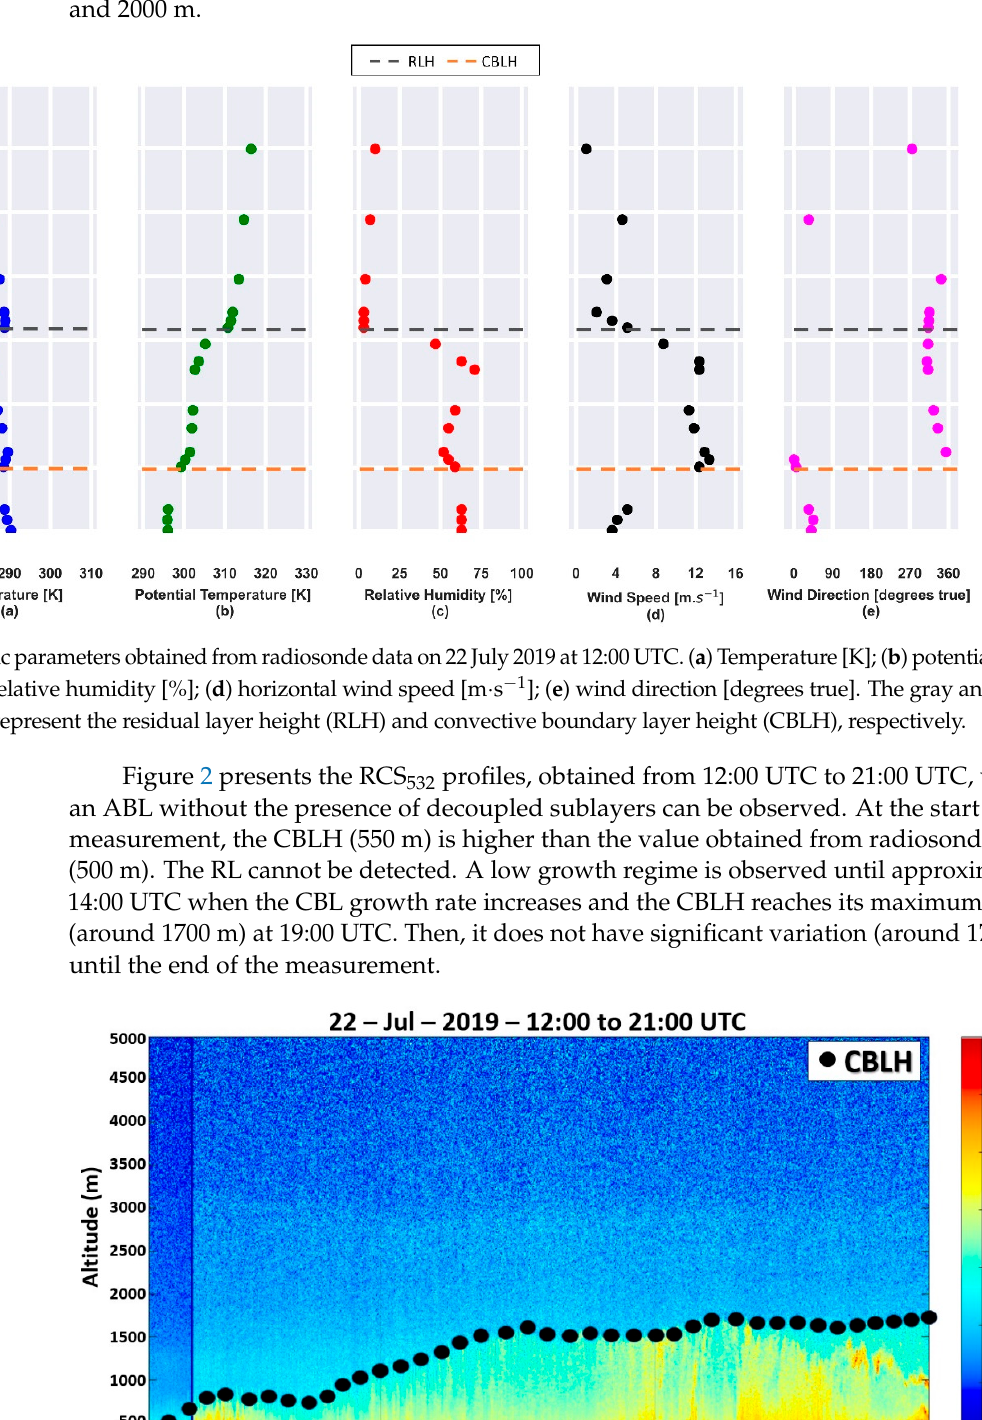
Figure 3. Atmospheric parameters obtained from radiosonde data on 23 July 2019 at 00:00 UTC. ( a ) Temperature [K]; ( b ) potential temperature [K]; ( c ) relative humidity [%]; ( d ) horizontal wind speed [m·s − 1 ]; ( e ) wind direction [degrees true]. The gray dashed line represents the RLH. Figure 4b presents the hourly-variation of AE (red dots) and the AOD (blue dots) between 13:00 UTC and 17:00 UTC. The increase in the AE between 13:00 and 14:00 UTC (0.73 to 1.42) indicates a reduction in the aerosols’ average size in the atmospheric column. Such a variation is accompanied by a reduction in the average AOD values (0.900 to 0.045). After 14:00 UTC, the AE decreases to lower values (indicating an increase in the aerosols’